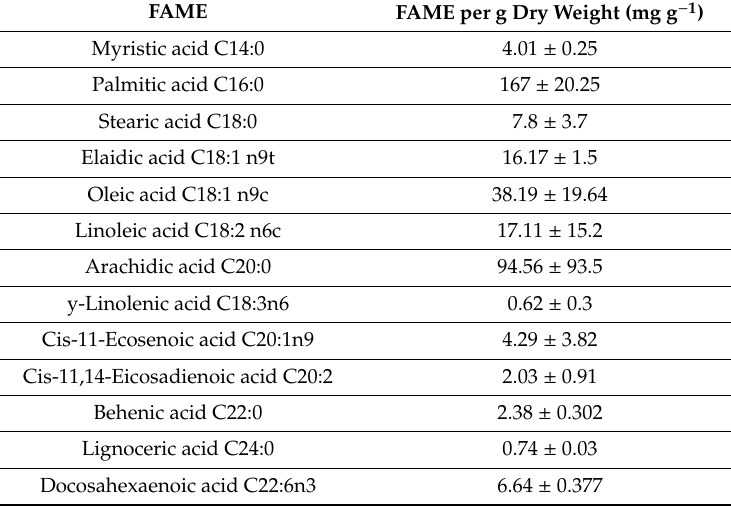
Table 2. Fatty acid composition of Chlorella sp. QUCCCM3, a C. sp . isolate from Qatar, after cultivation in BG11 medium for 12 days at 30 °C. Profile obtained via GC–FID, using a trans-esterified sample.